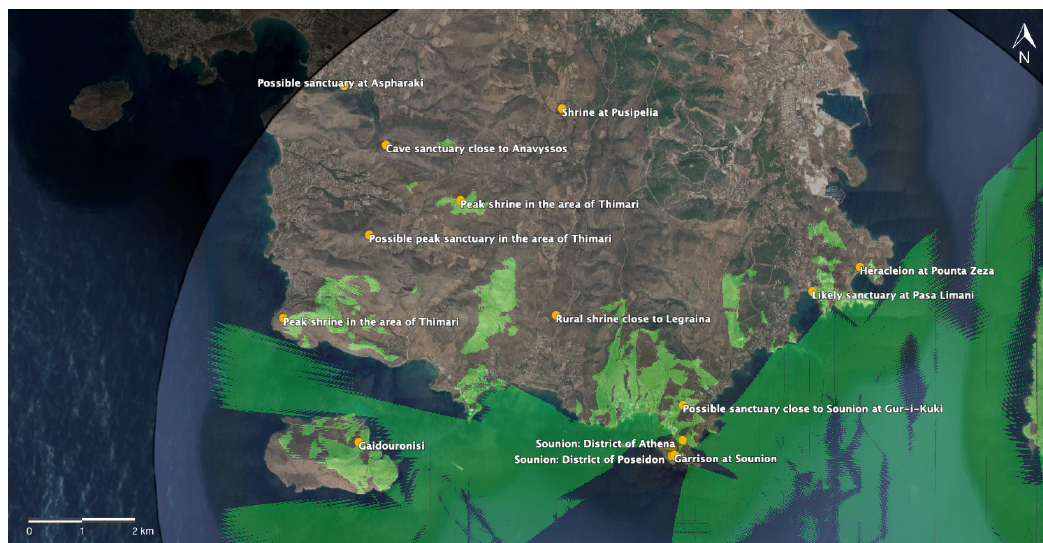
Figure 3. View shed analysis: areas visible from the Sounion garrison (M. Hunziker).